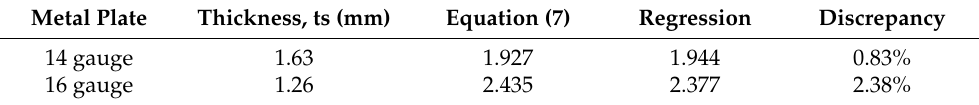
Table 8. Comparison of ∅ from proposed formula with ∅ derived from regression analysis. Metal